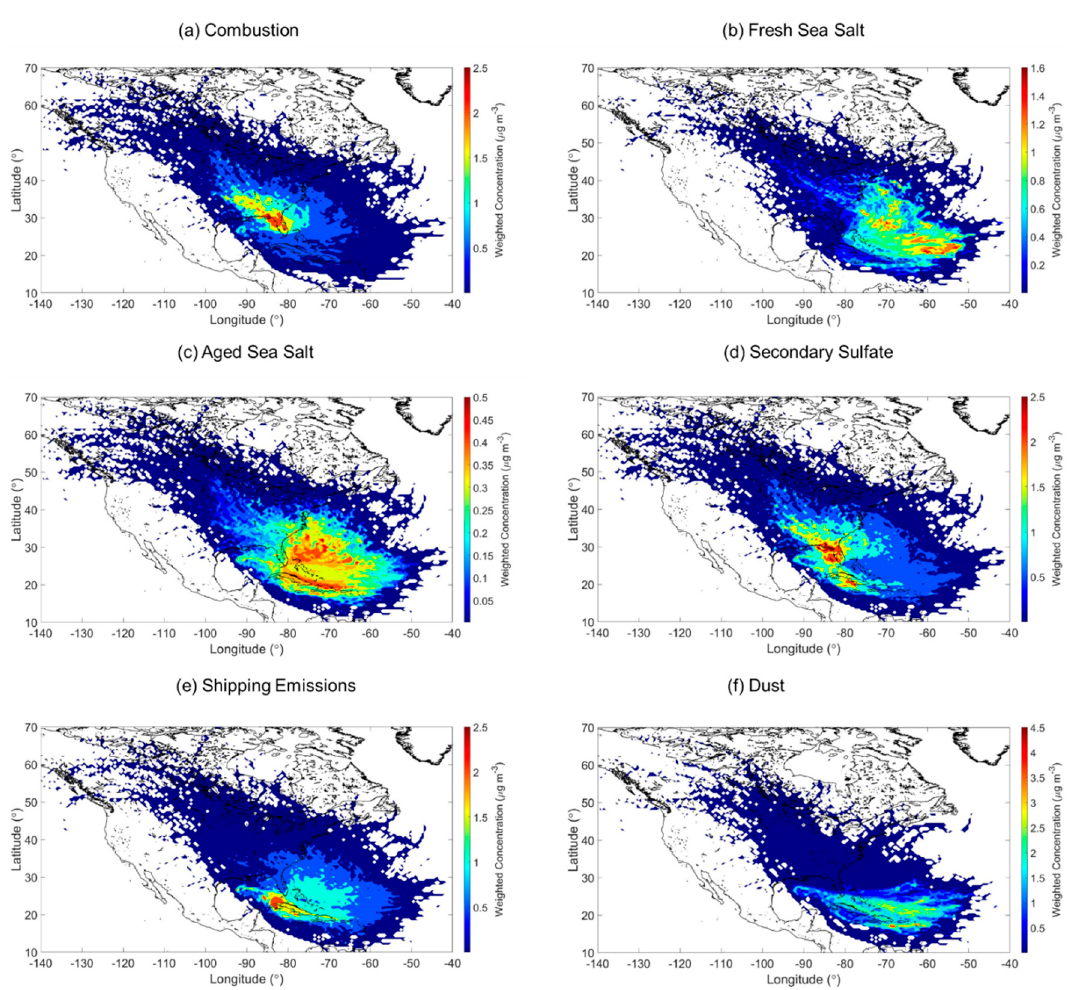
Figure 4. Annual mean weight concentration weighted trajectory (WCWT) maps of the six PMF source factors: ( a ) Combustion ( b ) Fresh Sea Salt ( c ) Aged Sea Salt ( d ) Secondary Sulfate ( e ) Shipping Emissions ( f ) Dust. Seasonal maps for each source factor are shown in Figures S1–S6.